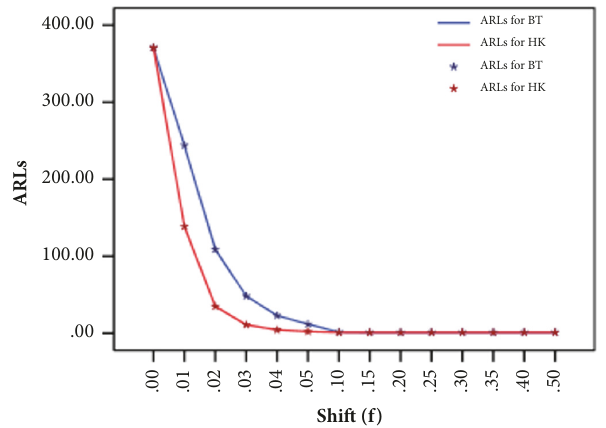
Figure 18: ARLs for proposed repetitive EWMA-RSS control charts using ratio estimators, for 𝜌 = 0.90 when 𝑟 𝑜 = 370 at 𝜆 = 0.1.